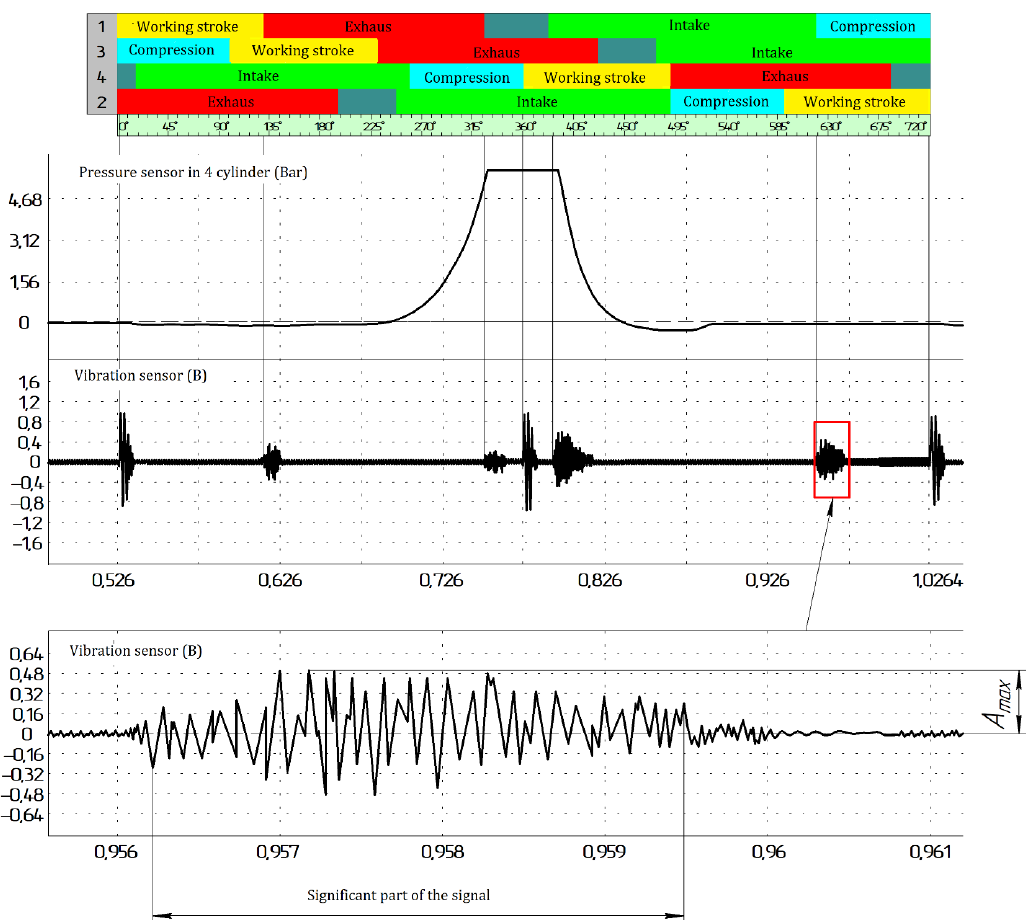
Figure 7. An oscillogram of the vibration sensor in a VAZ 21083 engine